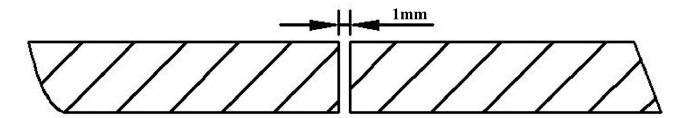
Figure 2. Schematic diagram of butt joints. Table 3. Optimum welding parameters of two welding methods for 5.5mm N6 plate Methods